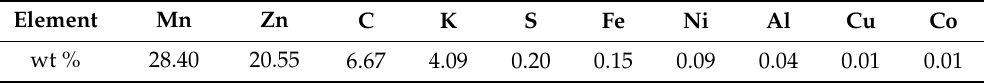
Table 2. Elemental composition of the mechanically-treated dry battery scrap fraction.